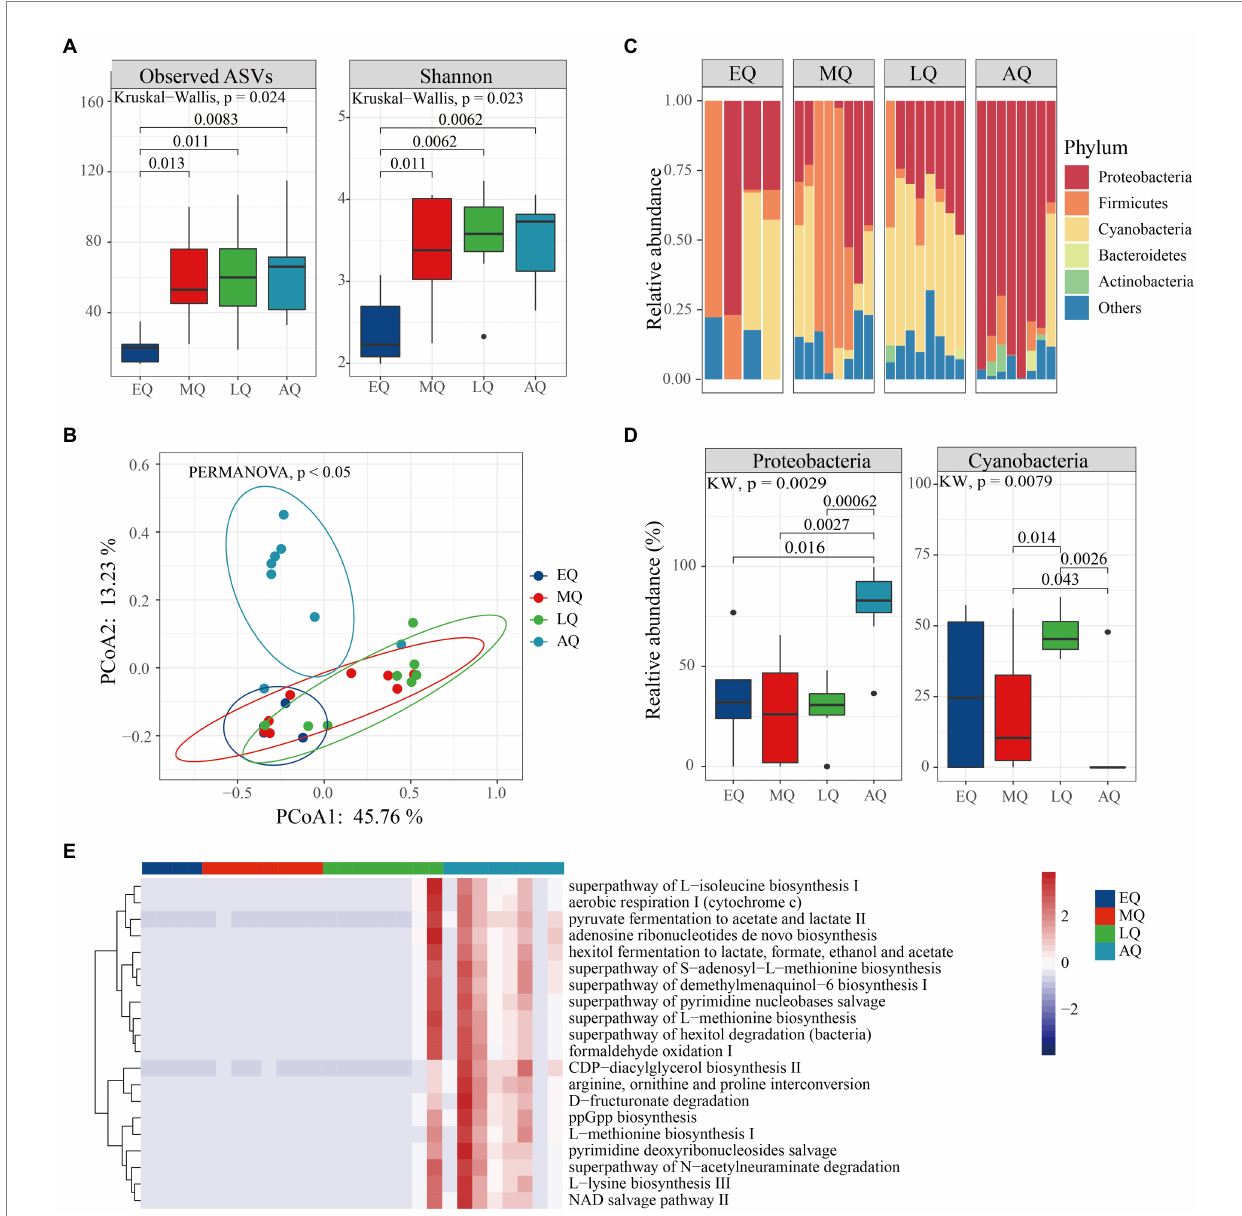
FIGURE 5 The variation of microbial diversity between four stages of queens in Bombus terrestris . (A) Alpha diversity (ASVs and Shannon indices) of microbiota in queen bumble bees using Kruskal–Wallis test. (B) PCoA plot based on Bray-Curtis distance metrics depicting the differences in microbial community structure (ES represents early larvae stage, MS represents mid larvae stage, LS represents late larvae stage. AS represents adult stage). (C) Phylum-level microbial composition of bumble bees. (D) The relative abundance of phyla was significantly different among the four groups (Kruskal–Wallis test, p < 0.05). (E) The relative abundance of the top 20 metabolic pathways using PICRUSt-predicted Metacyc